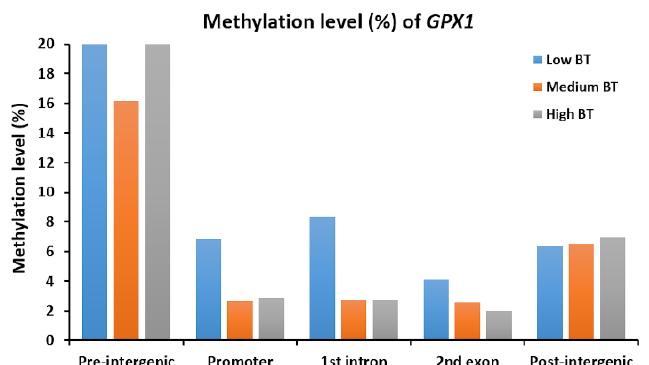
Figure 3. Methylation levels (%) of GPX1 in di ff erent gene components for low, medium and high BT